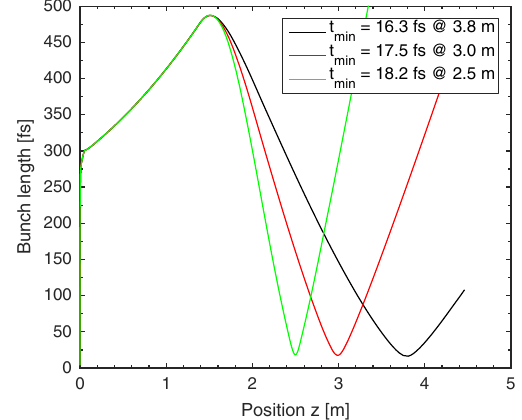
FIG. 2. The evolution of bunch length for different compression location in the velocity bunching scheme with parameters in Table I. The linac phase are − 77 °, − 85 °, − 92 ° for bunch compression at 3.8 m, 3.0 m, and 2.5 m, respectively.